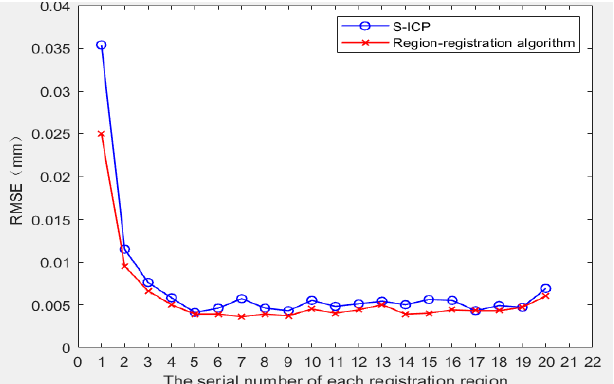
Figure 11. RMSE of each sub-region under two algorithms.